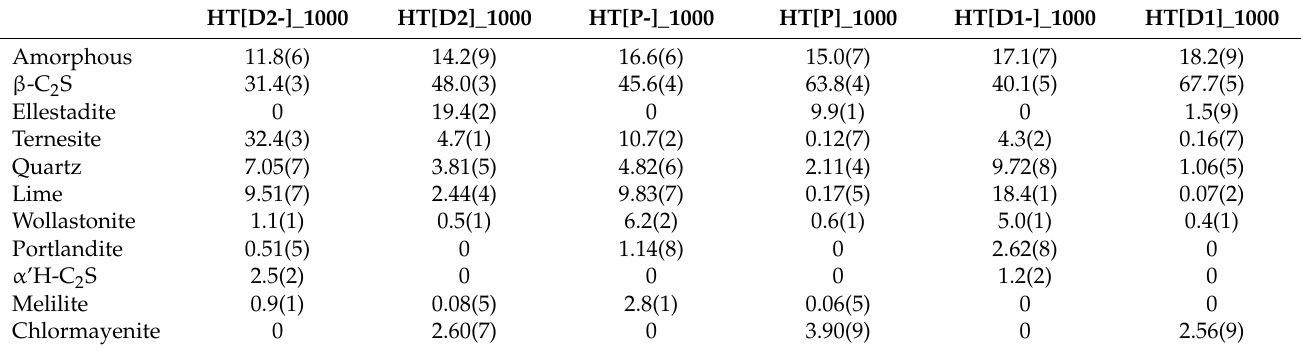
Table 2. Phase contents in wt% for samples heated to 1000 ◦ C with and without the addition of CaCl 2 . The samples contain additionally ≤ 0.5 wt%: CaCl 2 , Ca 2 SiO 3 Cl 2 ; ≤ 1 wt%: γ -C 2 S, anhydrite, spurrite, feldspar; ≤ 2 wt%: rusinovite, brownmillerite, merwinite, rondorfite. E.s.d.s of Rietveld refinements are given in